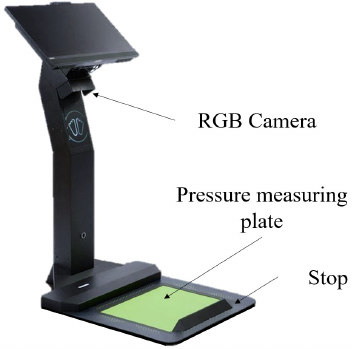
Figure 4. Feetbox Evo Scanner for foot size determination